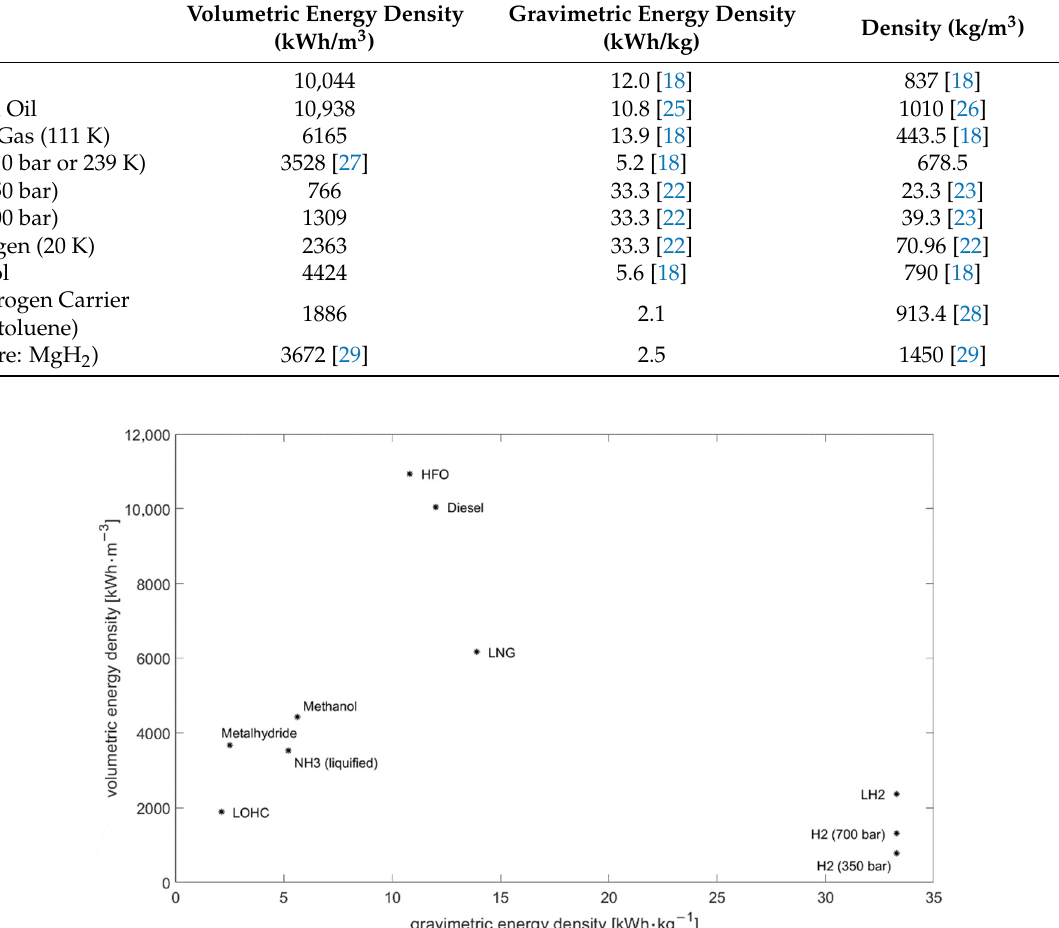
Table 1. Comparison of the energy density of different energy carriers.